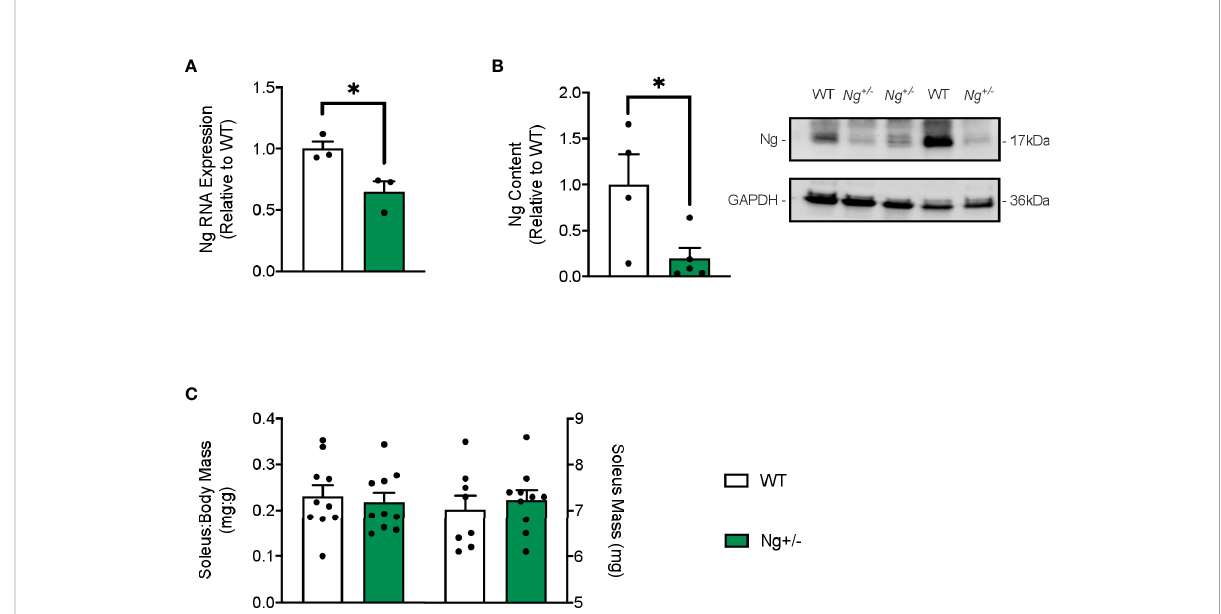
FIGURE 1 Neurogranin is reduced in the soleus muscles of Ng +/- mice but the soleus:body weight ratio is unchanged. Neurogranin expression in the soleus muscle of WT and Ng +/- mice was assessed via RT-PCR (A) and western blotting (B) and was found to be signi fi cantly reduced in Ng +/- mice compared to WT. The soleus:body weight ratios (mg:g) and soleus weights (mg) were unchanged between genotypes (C) . * p < 0.05 (n=3- 4 per group (A,B); n=10 per group (B)